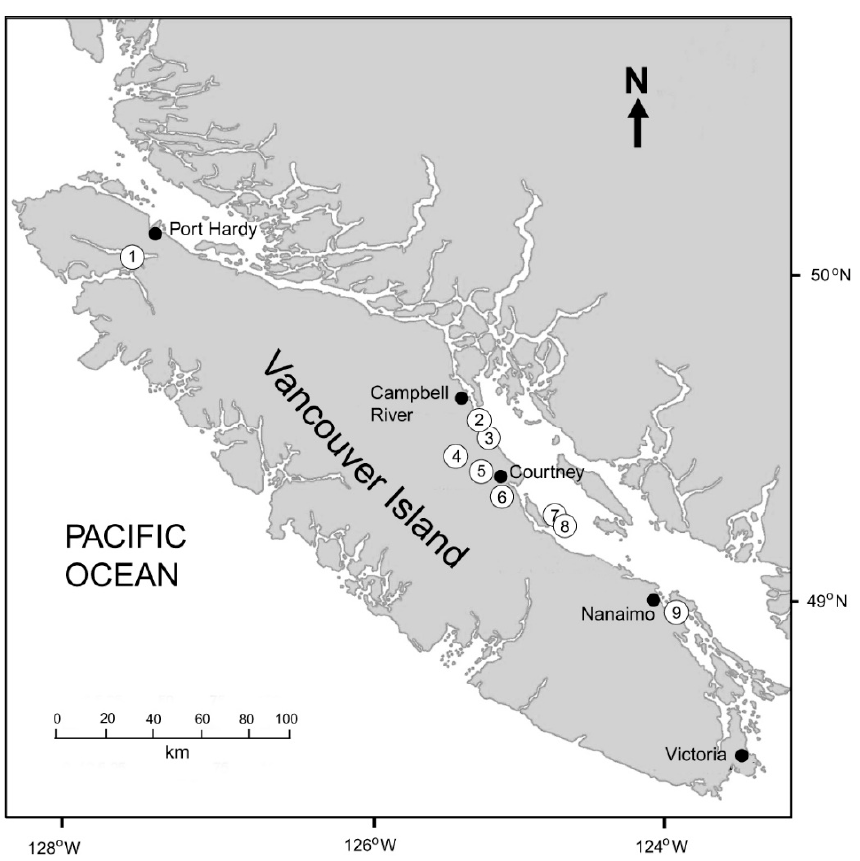
Figure 1. Vancouver Island plant fossil locations. ( 1 ). Apple Bay; ( 2 ). Shelter Point; ( 3 ). Appian